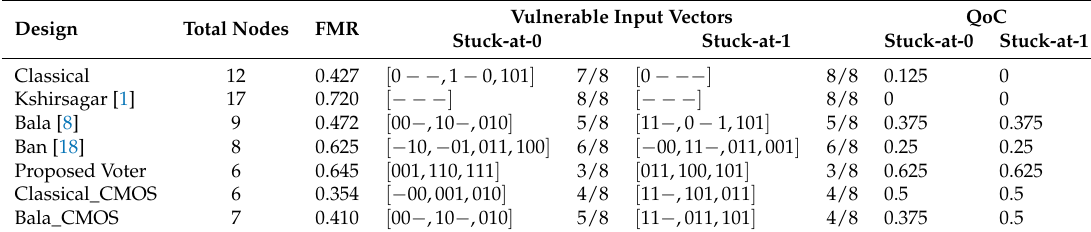
Table 2. Internal Fault-Tolerance Capabilities of the Voters.